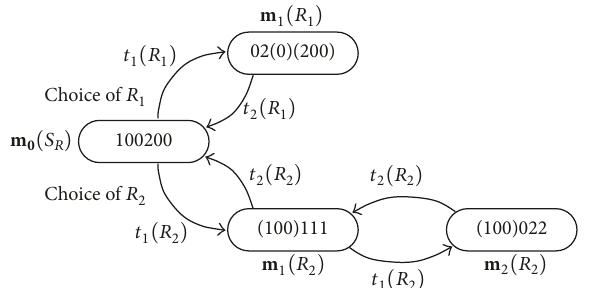
Figure 5: Reachability graphs of the Petri nets 𝑅 1 and 𝑅 2 .